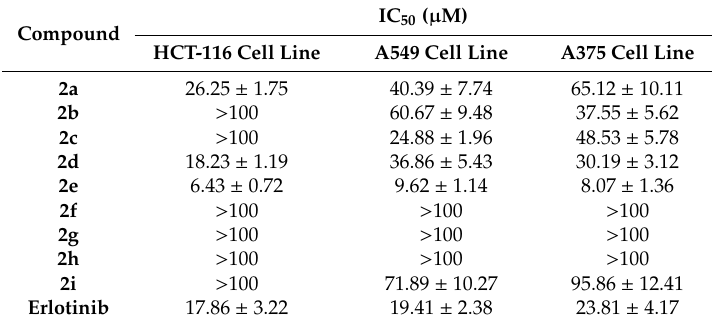
Table 1. The cytotoxic e ff ects of compounds 2a–i on HCT-116, A549, and A375 cell lines.